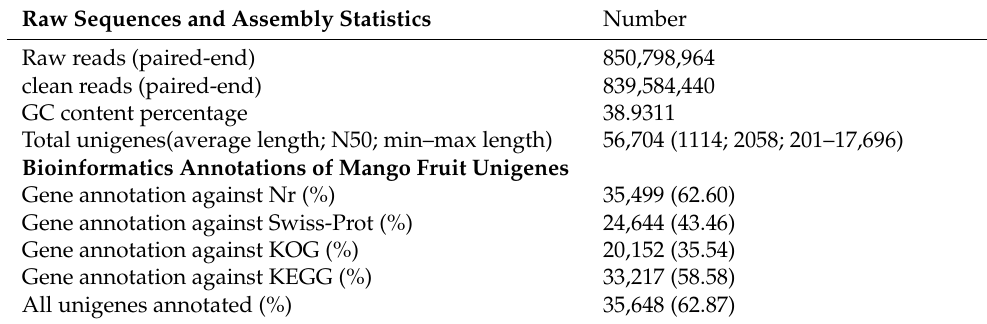
Table 2. Summary of transcriptome data for mango fruit as well as detailed bioinformatics annotations and analyses.